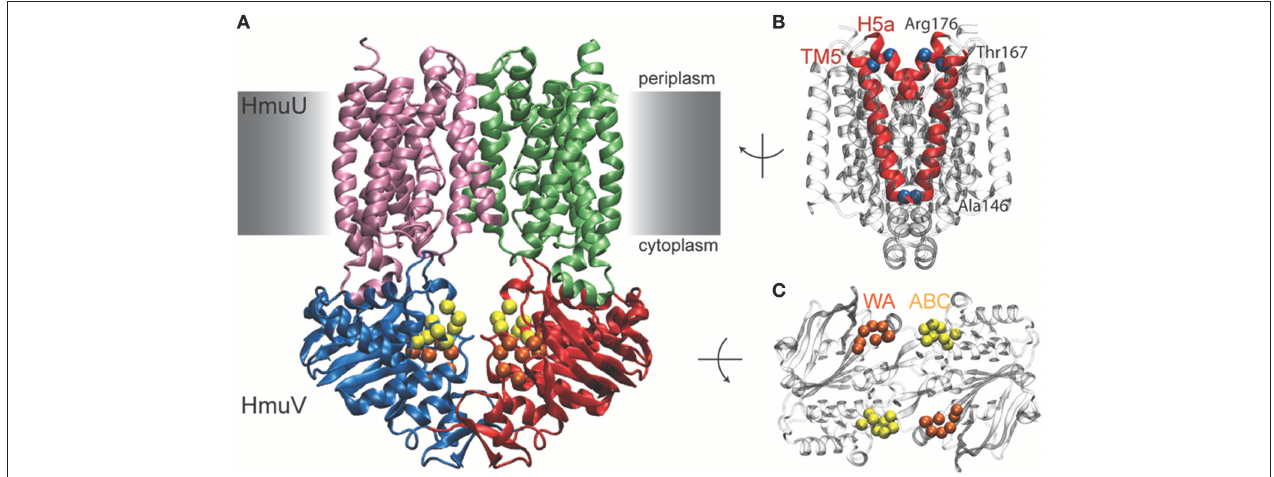
FIGURE 6 | Nucleotide-free conformation of HmuUV heme transporter. (A) Structure of the heme transporter in ribbon representation. The domain coloring is similar to that of the maltose transporter and the conserved Walker A and ABC signature motifs from the NBDs are also highlighted similar to previous figures. They form two open nucleotide-binding pockets as shown in the top view of the isolated NBDs (shown in C ). (B) Transmembrane helix 5 (TM5) and helix 5a (H5a) of both TMD chains are highlighted in red. In the chosen side view perspective they constitute a cone-shaped cavity which is sealed at the cytoplasmic side. Residues near the periplasmic and cytoplasmic side, whose positions have been followed during the simulations, are depicted as blue alpha-carbon beads.